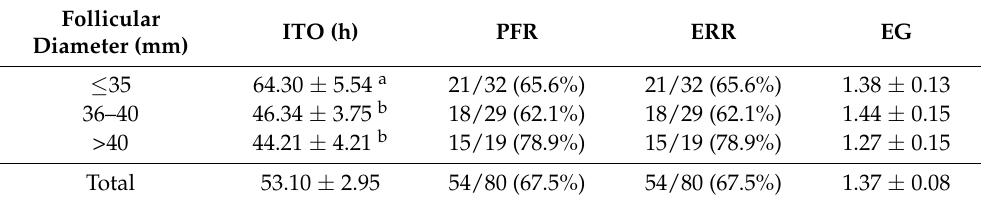
Table 9. Effect of follicular diameter at time of treatment ( ≤ 35 mm, 36–40 mm, >40 mm) on interval to ovulation (ITO), positive flushing rate (PFR), embryo recovery rate (ERR) and embryo morphological grade (EG) in jennies. ITO (h) PFR ERR EG ≤ 35